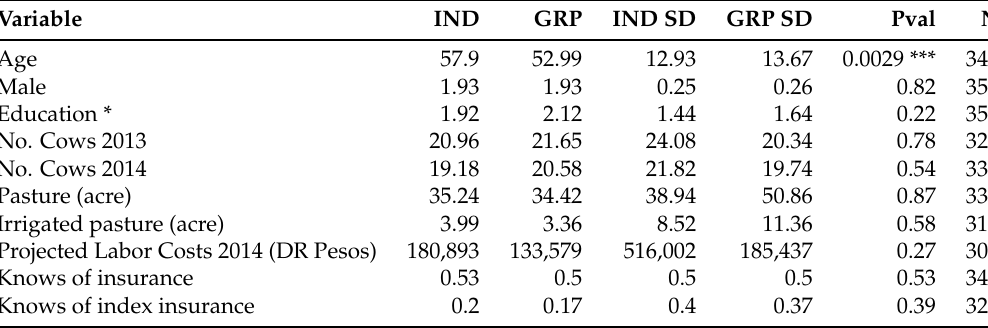
Table 2. Balance Across Group (GRP) and Individual (IND)